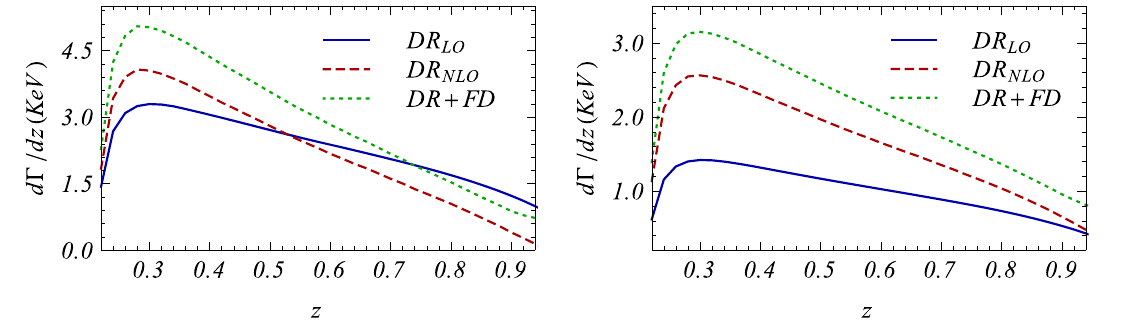
Fig. 5 The ϒ( 1 S ) energy distributions in Z → ϒ( 1 S ) + g + g . z = 2 E ϒ( 1 S ) and m b = 4 . 9 GeV. “NLO” represents the sum of the con- m Z tribution of the LO terms and that of the QCD corrections. μ r = 2 m b